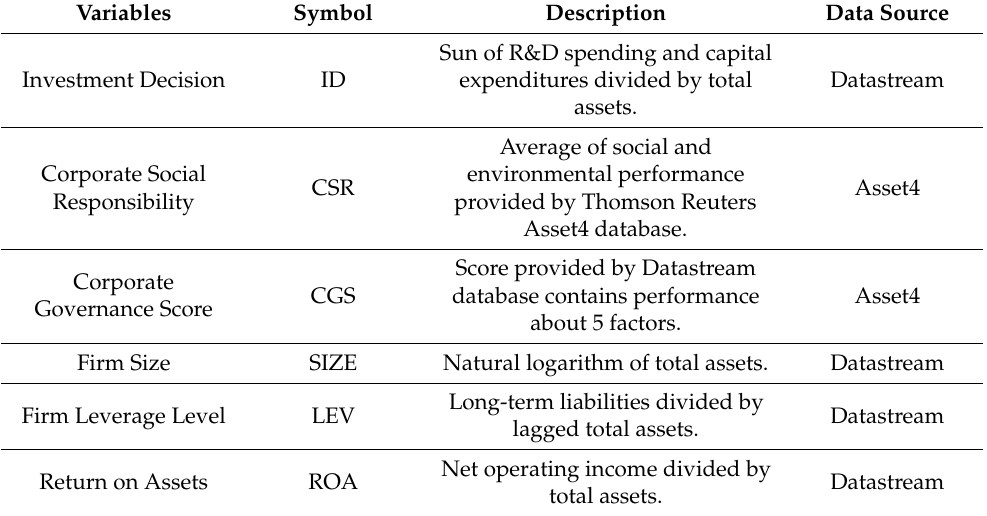
Table A1. Variables